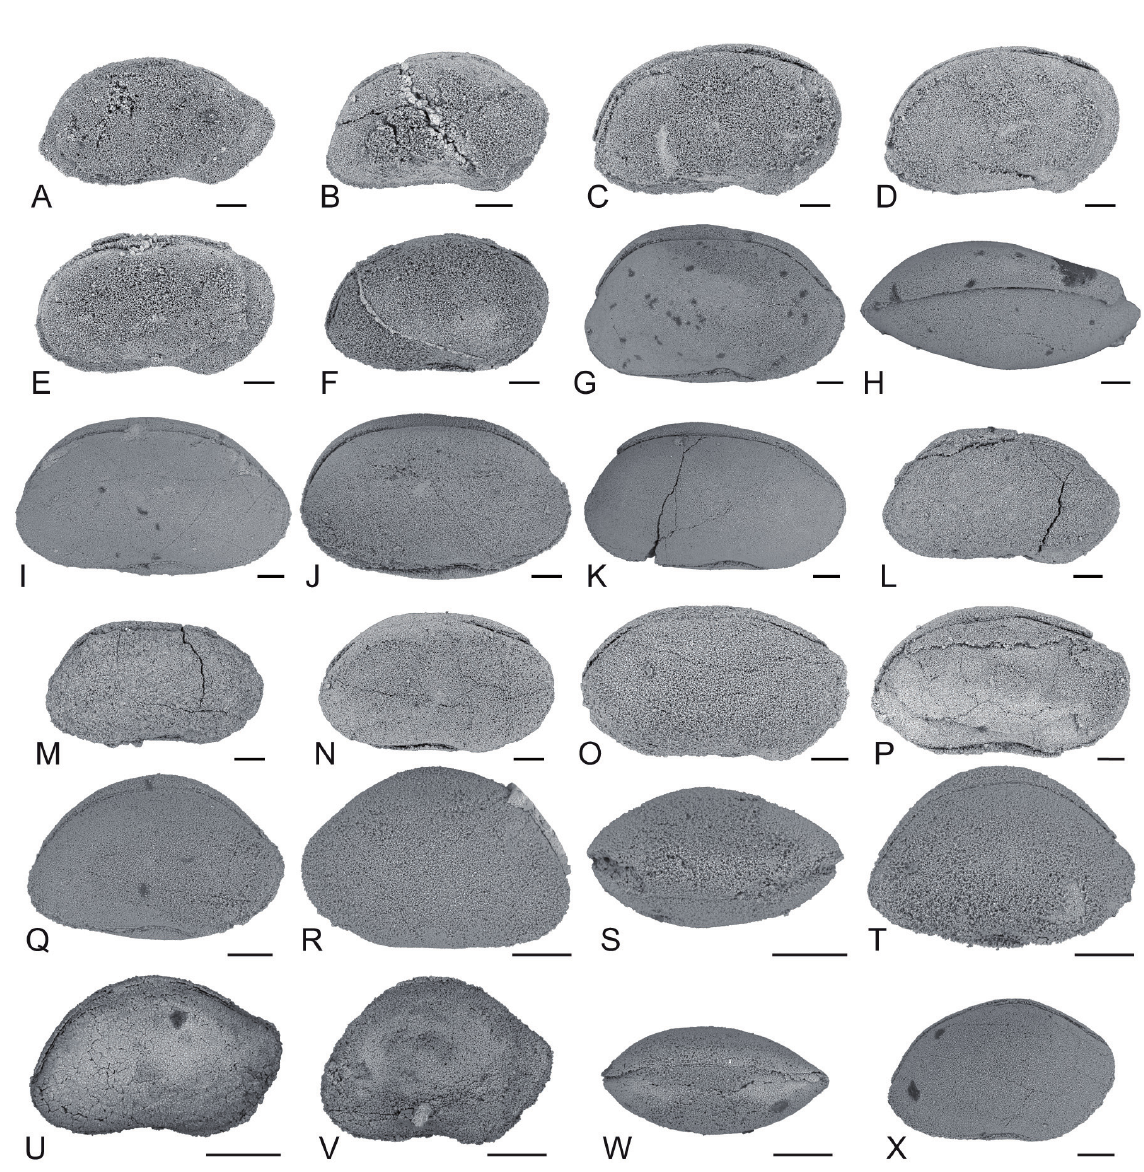
Fig. 4. Ostracods from the Dajiang section, South China. — A–F . Bairdia ? huberti sp. nov. A . Carapace, right lateral view, P6M2939. B . Carapace, right lateral view, P6M2940. C . Paratype, carapace, right lateral view, P6M2941. D . Holotype, carapace, right lateral view, P6M2942. E . Carapace, right lateral view, P6M2943. F . Carapace, right lateral view, P6M2944. — G–P . Bairdia jeromei sp. nov. G . Holotype, carapace, right lateral view, P6M2945. H . Carapace, dorsal view, P6M2946. I . Carapace, right lateral view, P6M2947. J . Paratype, carapace, right lateral view, P6M2948. K . Carapace, right lateral view, P6M2949. L . Carapace, right lateral view, P6M2950. M . Carapace, right lateral view, P6M2951. N . Carapace, right lateral view, P6M2952. O . Carapace, right lateral view, P6M2953. P . Carapace, right lateral view, P6M2954. — Q–T . Bairdia limatusformis Forel, 2010. Q . Carapace, right lateral view, P6M2955. R . Carapace, left lateral view, P6M2956. S . Carapace, sub-dorsal view, P6M2957. T . Carapace, right lateral view, P6M2958. — U–V . Bairdia sp. 1. U . Carapace, right lateral view, P6M2959. V . Carapace, right lateral view, P6M2960. — W–X . Bairdia sp. 2. W . Carapace, dorsal view, P6M2961. X . Carapace, right lateral view, P6M2962. – Scale = 100